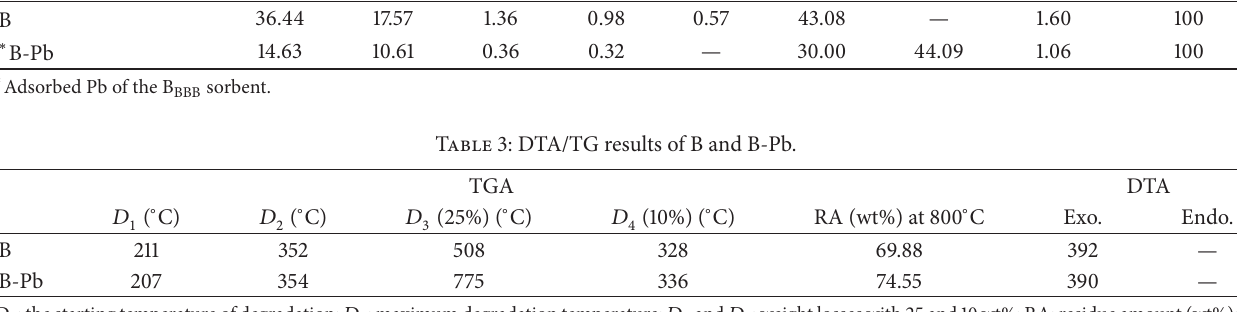
respectively. The plot of ln (𝑞 𝑒 − 𝑞 𝑡 ) versus 𝑡 for pseudo- first-order kinetics showed a linear relationship. The slope and intercept of ln (𝑞 𝑒 − 𝑞 𝑡 ) versus 𝑡 were used to calculate the pseudo-first-order rate constant 𝑘 1 and 𝑞 𝑒, Table 5. Equation (3) was used for the pseudo-second-order kinetic model [30, 31]: